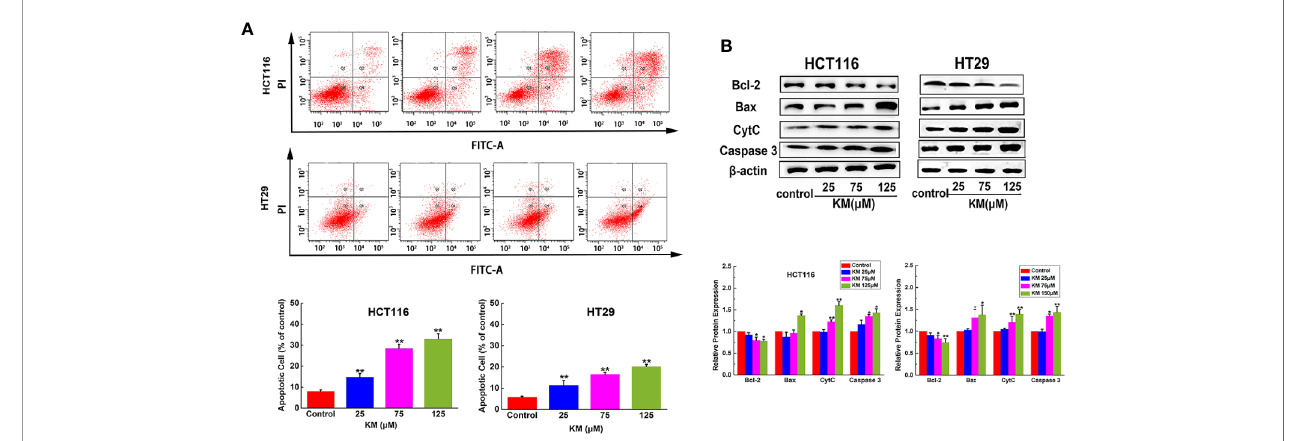
FIGURE 3 | KM promoted CRC cells apoptosis in a dose-dependent manner. (A) Flow cytometric analysis of HCT116 and HT29 cell apoptosis after incubation with KM for 24 h. (B) Western blot and quanti fi cation of proteins associated with apoptosis (Bcl-2, Bax, Cyt-C and caspase 3) in HCT116 and HT29 cells after incubation with KM for 24 h. Data were presented as mean ± SD (n = 3); signi fi cance: * P < 0.05, ** P < 0.01 vs